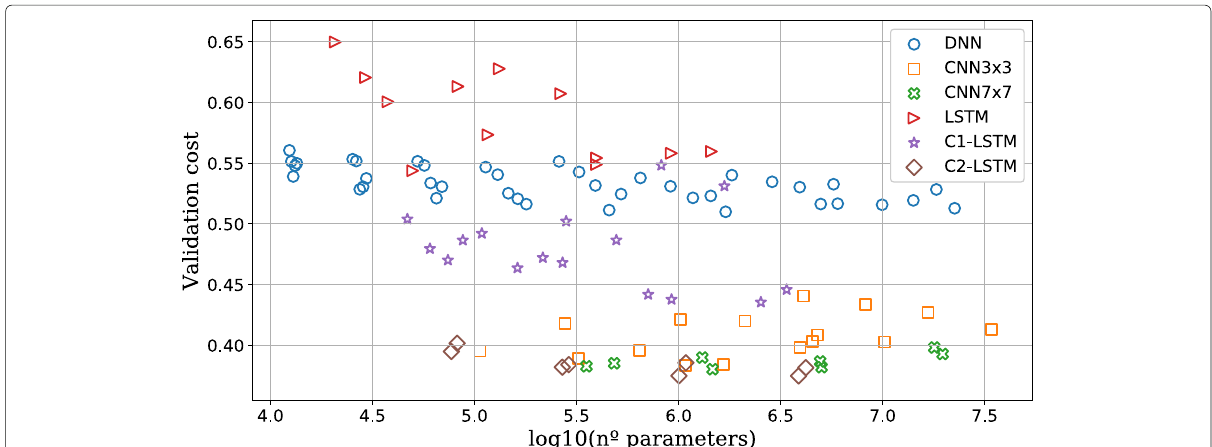
Fig. 4 Speech event detection validation cost across the evaluated models. Each point in the scatter plot represents one of the trained networks, and its position along the horizontal and vertical axes indicates the number of parameters (in a logarithmic scale) and the validation cost obtained,